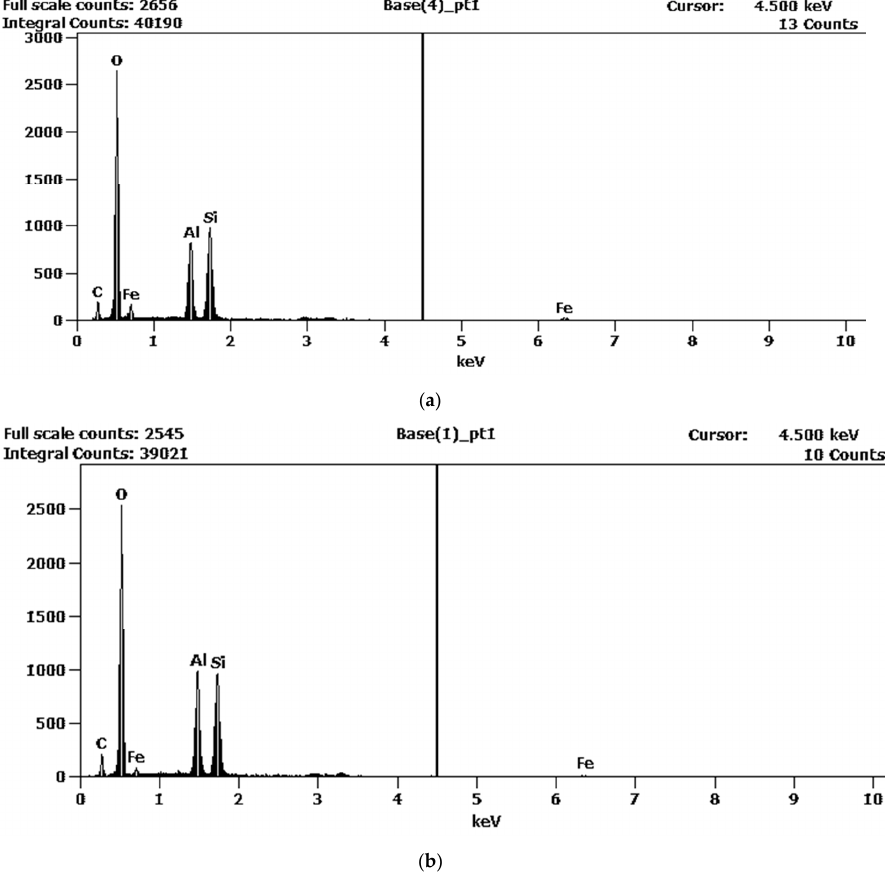
Figure 11. Steel sample surface after the wear tests; 1—aggregates of clay coal abrasive material.